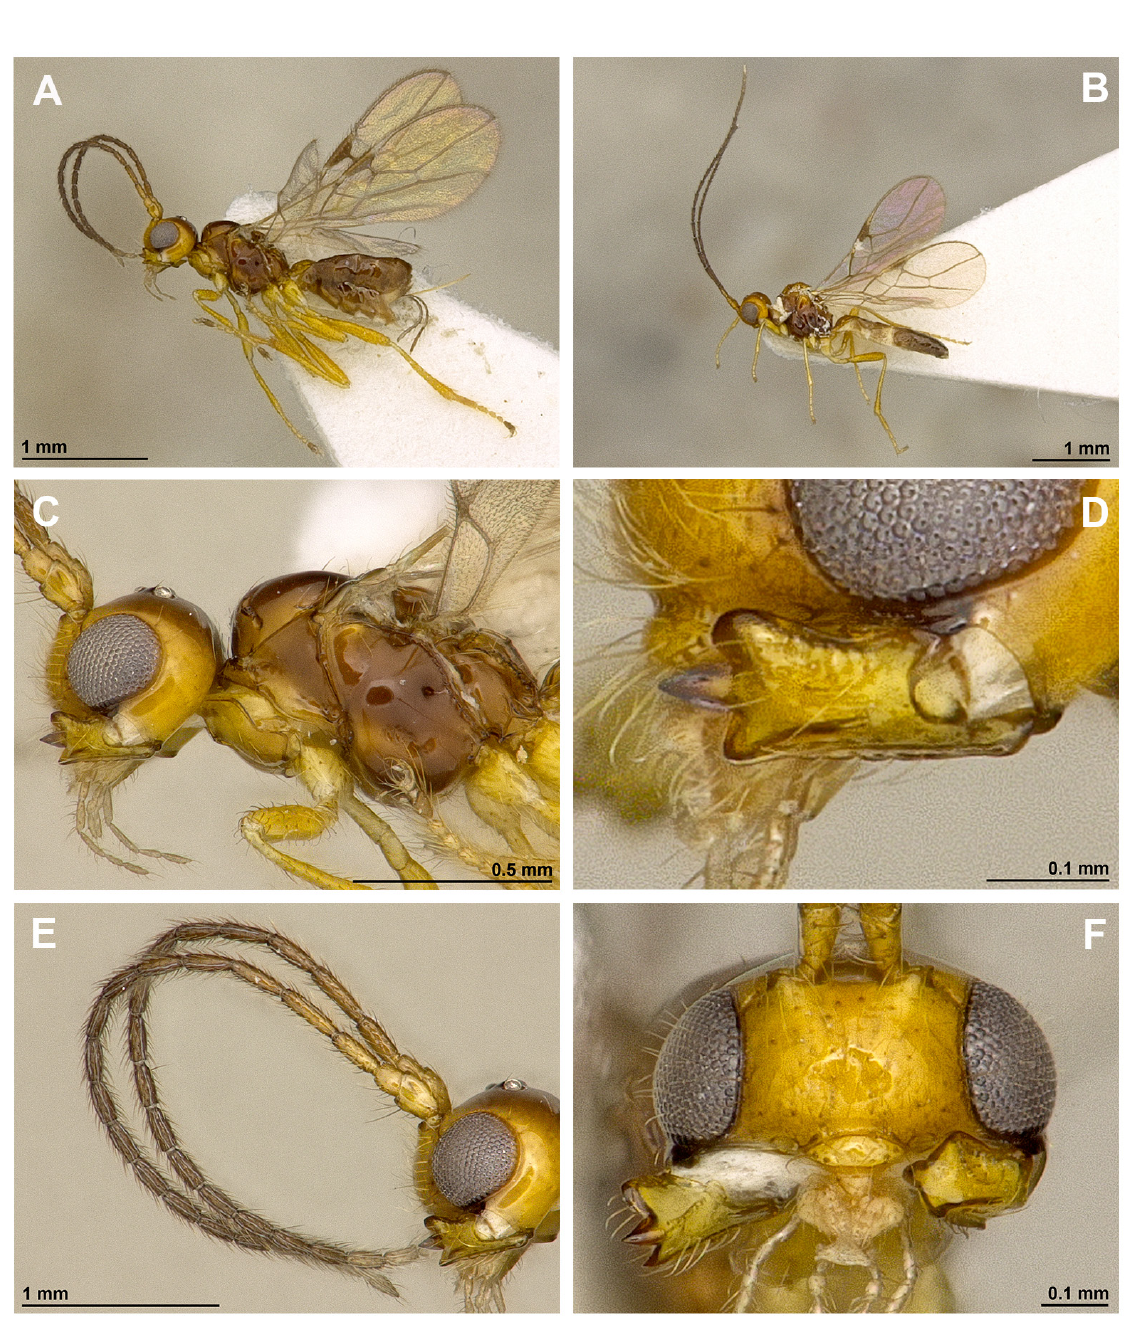
Fig. 70. Asobara vanalpheni van Achterberg, sp. nov., A, C–F: ♀, holotype (RMNH); B: ♂ (RMNH, FJPF, ZISP). A–B . Habitus, lateral view. C . Head and mesosoma, lateral view. D . Mandible. E . Antenna. F . Head, front